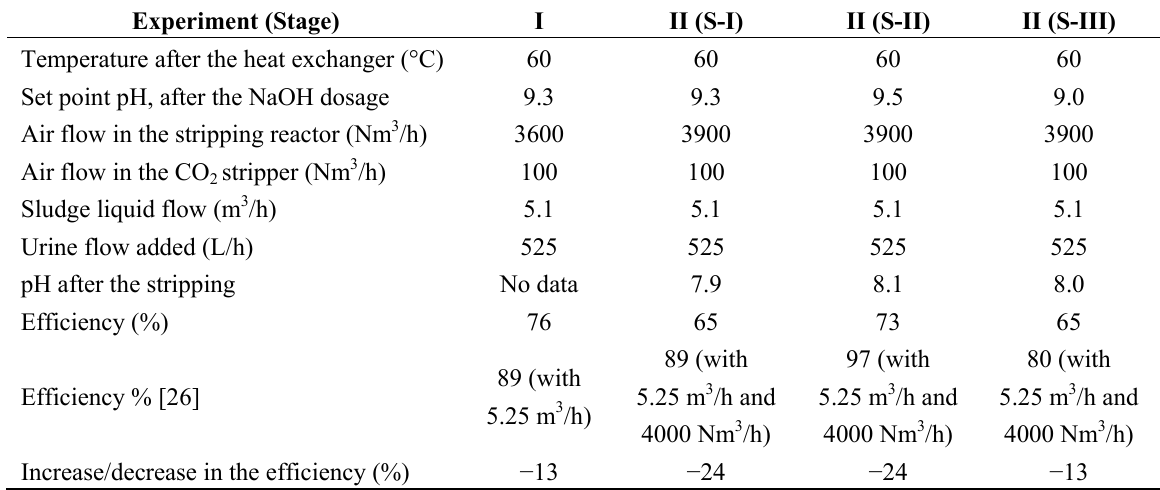
Table 6. Summary of the main results of the different